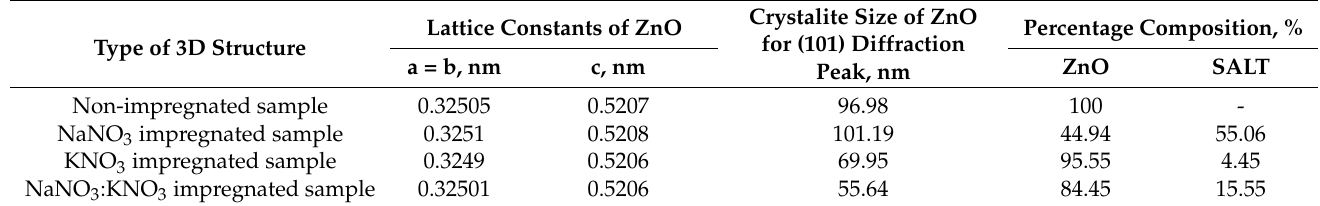
Table 1. Results of the XRD analysis concerning the effect of impregnation on the structural parame- ters of ZnO phase of 3D support structures.